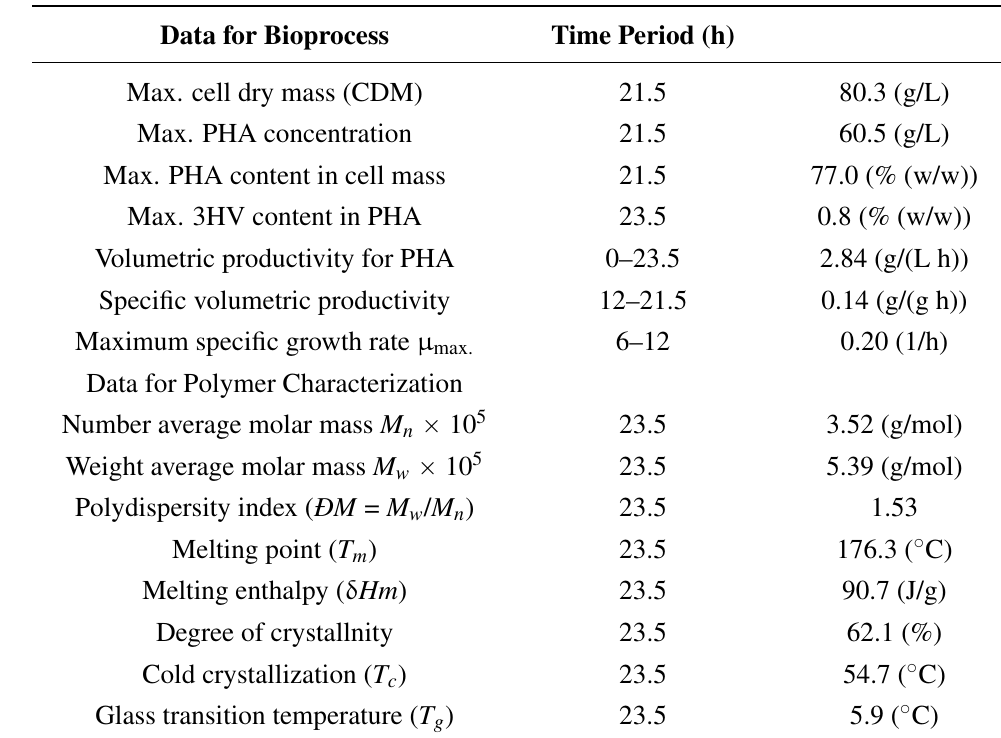
Table 2. Main results of the bioreactor fermentation: Kinetics and polymer